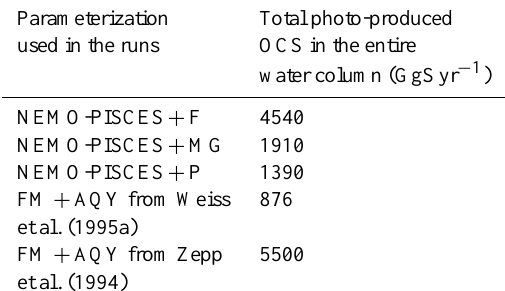
Table 1. Annual global photo-production of OCS in the entire water column simulated with the NEMO-PISCES model (using the three different a 350 formulations presented in this paper) or with the pho- tochemical model derived from Fichot and Miller (2010) (FM in the table) (using two different apparent quantum yields